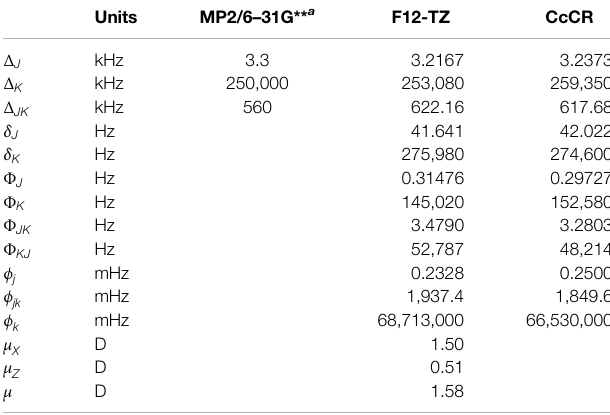
TABLE 2 | Quartic and sextic spectroscopic